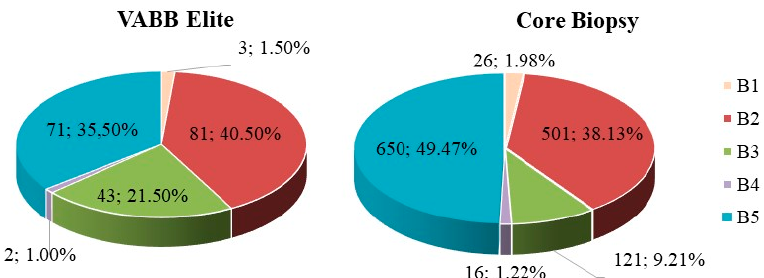
Figure 8. Percentage distribution (and absolute values) of the micro-histological biopsy results carried out by means of the two procedures Elite VABB and CB using 14–16G core needle.